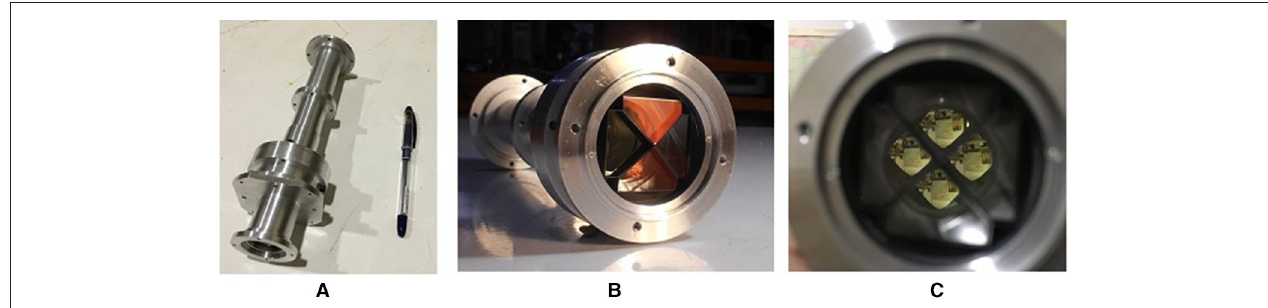
FIGURE 14 | The channel of multispectral imager-polarimeter MSIP prepared for laboratory test. (A) MSIP channel without matrix unit, (B) prism splitter, (C) four images after prism splitter.